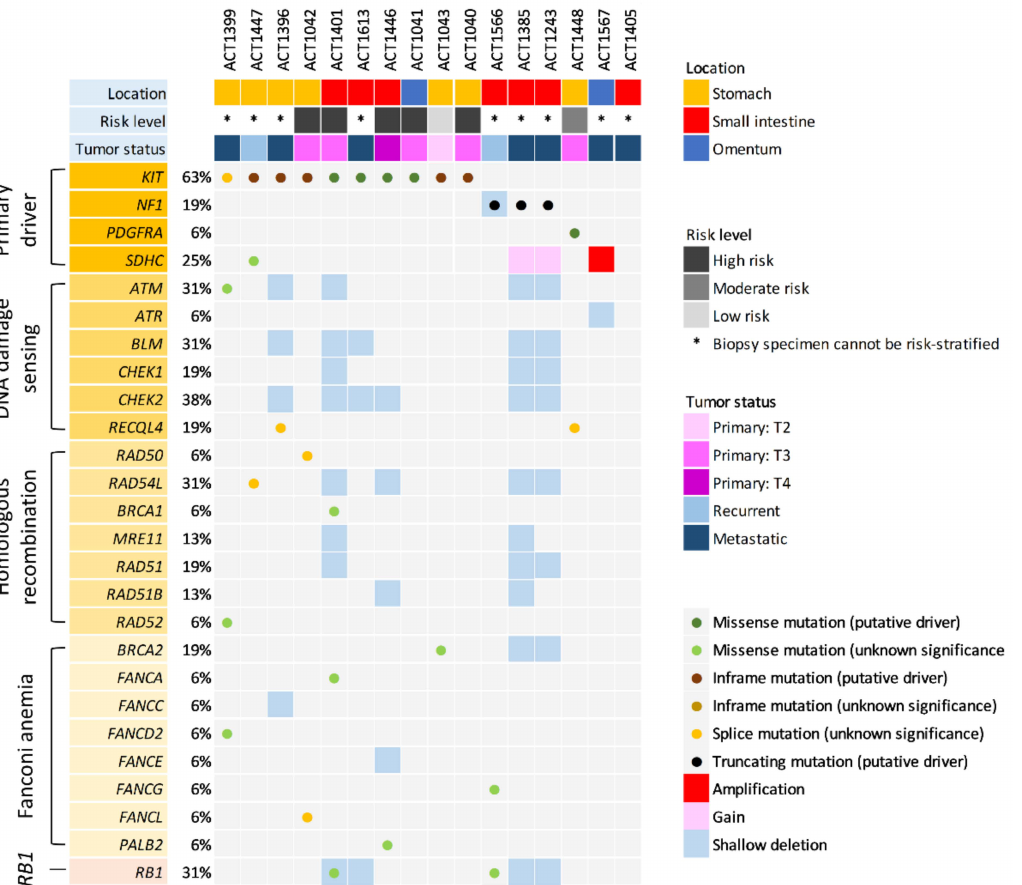
Figure 1. Mutational landscape of GISTs in RB1 and homologous recombination repair-related genes: Types of aberrations are annotated and catalogued into DNA damage-sensing, homologous recombination, and Fanconi anemia pathways, and RB1 as indicated by the color codes at the bottom. Note that DNA damage-sensing genes, e.g., CHEK2 , are preferentially targeted by heterozygous deletion (HetDel) in contrast to another two groups mainly affected by isolated SNVs, such as missense or splicing mutations. Note that 2 of 16 samples exhibited co-occurring HetDels of RB1 and BRCA2 with close proximity to each other on 13q. Columns represent individual tumors and rows represent individual aberrated genes. DNA damage repair genes are collated based on the prevalence of CNVs and SNVs/indels, following the primary GIST-driving mutations ( KIT , PDGFRA , NF1 , SDHC ) and the baseline clinicopathologic characteristics, including tumor locations, NCCN risk levels, and status of tumor specimens. Asterisks indicate biopsy samples not amenable to precise risk-stratification by